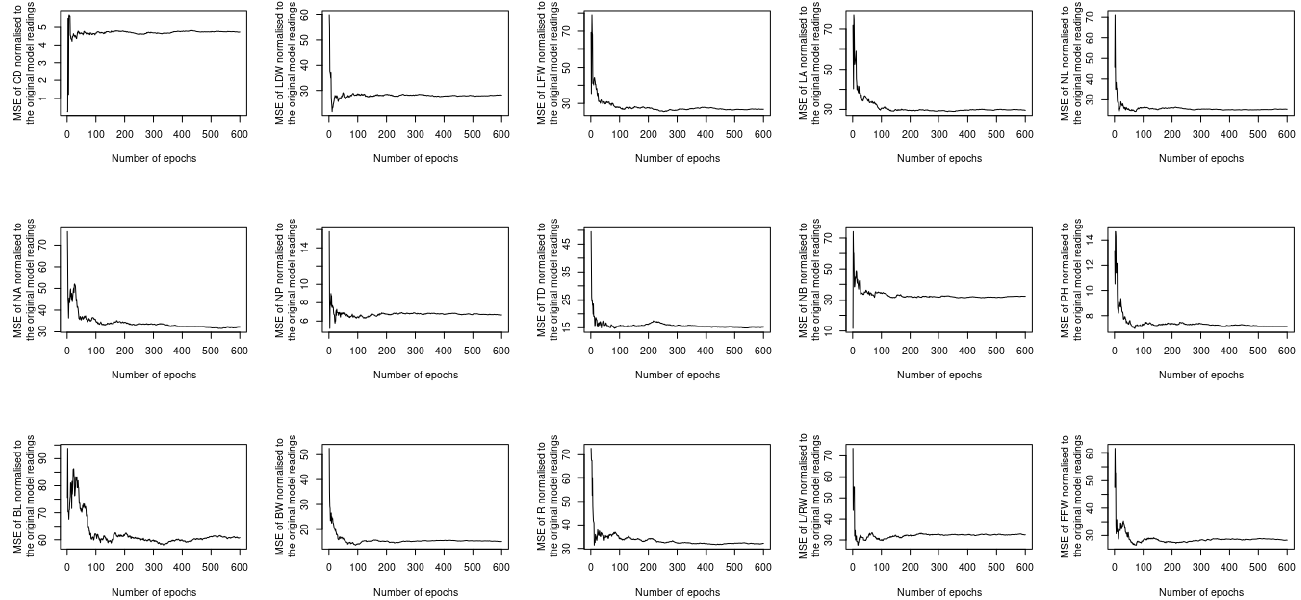
Figure 13. MSE of the newly constructed models normalized to the original model .